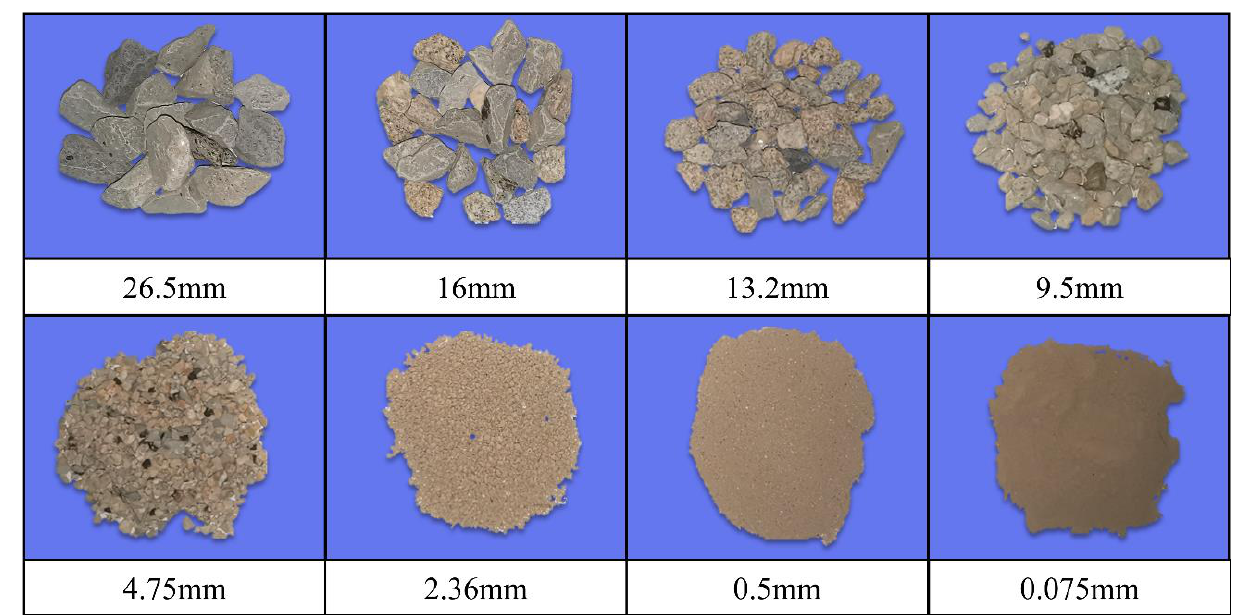
Figure 1. Illustration of aggregate materials within the different size ranges from sieve analysis.